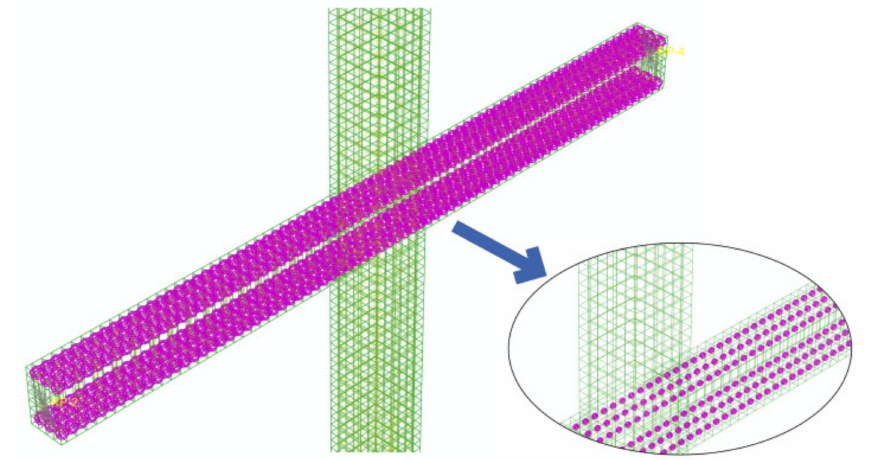
Figure 6. Spring cell